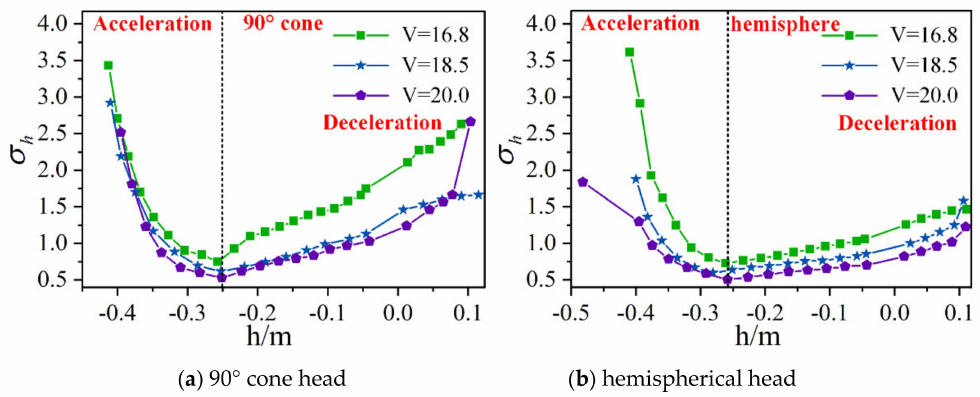
Figure 11. Variation curve of the local cavitation number of two head forms at different speeds.